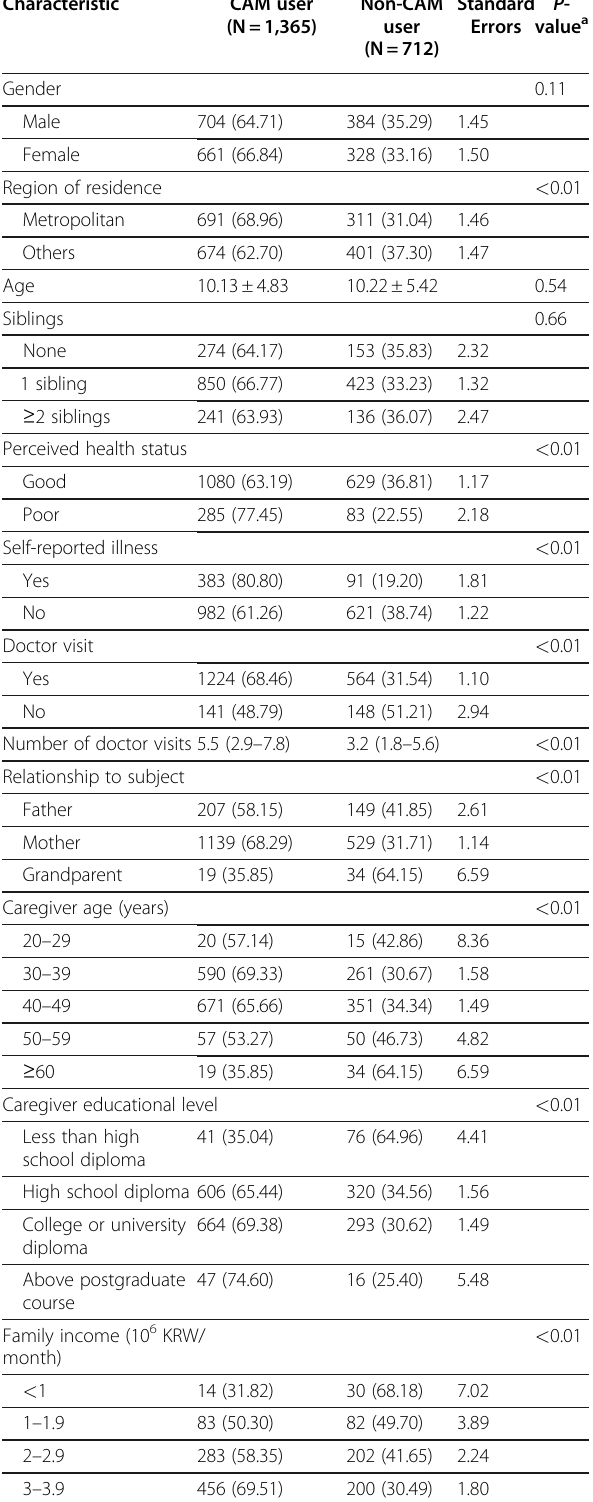
Table 1 Characteristics of the study participants according to the use of complementary and alternative